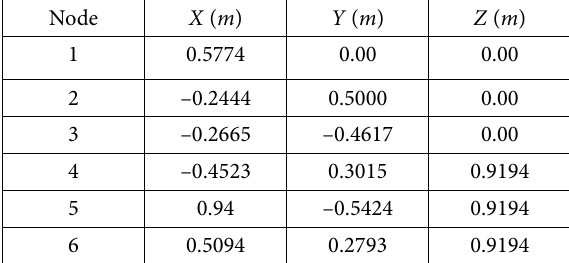
Table 1.Initial coordinates of the tripod simplex structure